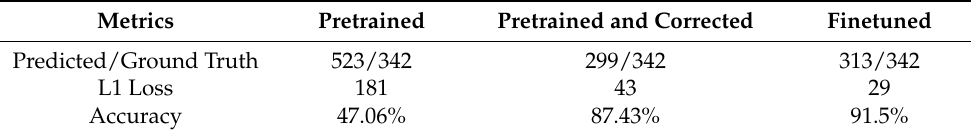
Table 5. Results of the proposed pipeline running on a video clip of apples. We show the predicted count versus the actual count and compute the L1 Loss and Accuracy. The accuracy was low with the pretrained weights due to a significant overcount. Our correction mechanism substantially improved the accuracy, however fine tuning the weights led to the best